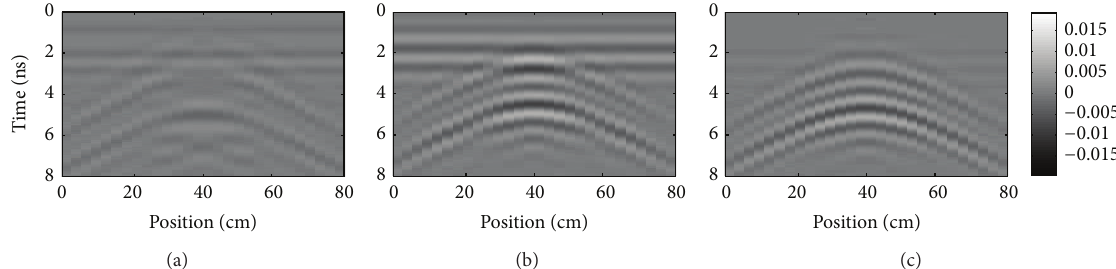
Figure 3: GPR B-scan synthetic radargrams for a basalt sphere of 5cm radius, buried 10cm deep from an air/sand interface. Grey-scale received-signal amplitude in time versus longitudinal scanning position along 𝑥 , for three parallel lines at different 𝑦 : (a) line 1; (b) line 5; (c) line